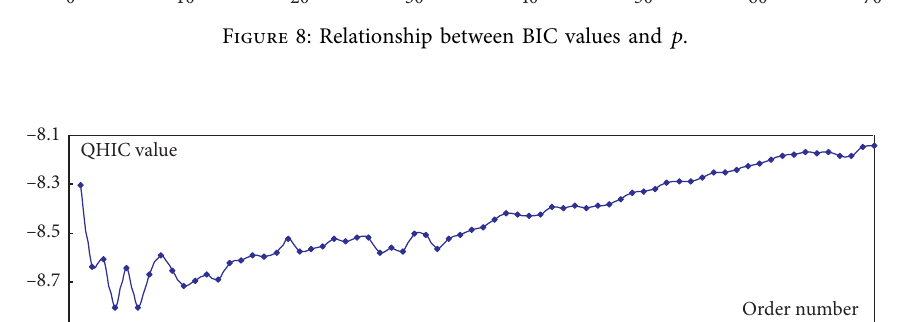
Figure 8: Relationship between BIC values and p .